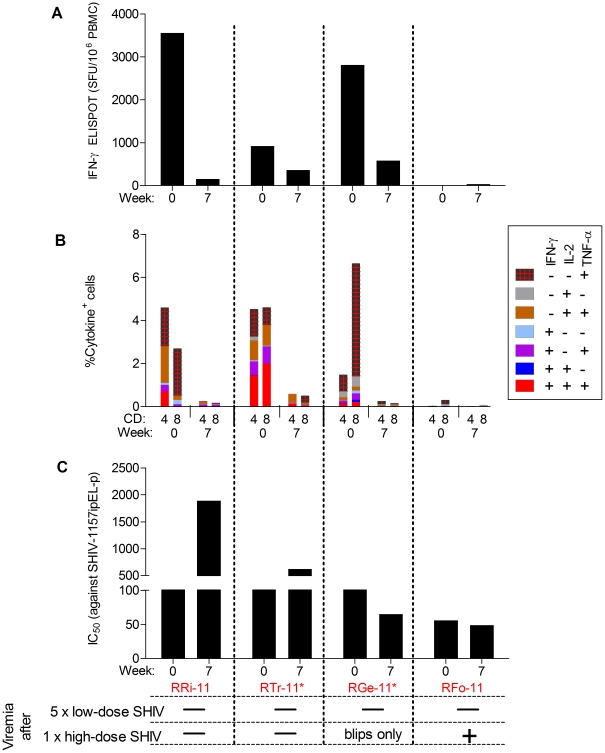
Immune responses on the day of high-dose virus challenge.Cellular and nAb responses at week 0 (day of first virus exposure) and week 7 (day of high-dose virus challenge) for: (A) SIV Gag- and HIV-1 Tat-specific IFN-γ ELISPOT responses. (B) SIV Gag and HIV-1 Tat-specific peripheral blood CD4+ and CD8+ T cells producing intracellular IFN-γ, IL-2 & TNF-α (measured by multiparameter flow cytometry). (C) nAb titers against the challenge virus (IC50 measured by TZM-bl assay).